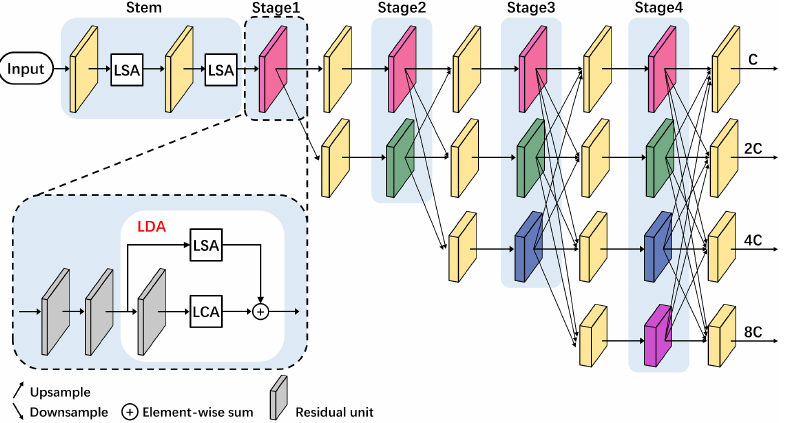
Figure 3. The overall architecture is divided into three parts, from left to right are the backbone, segmentation head, and loss functions.